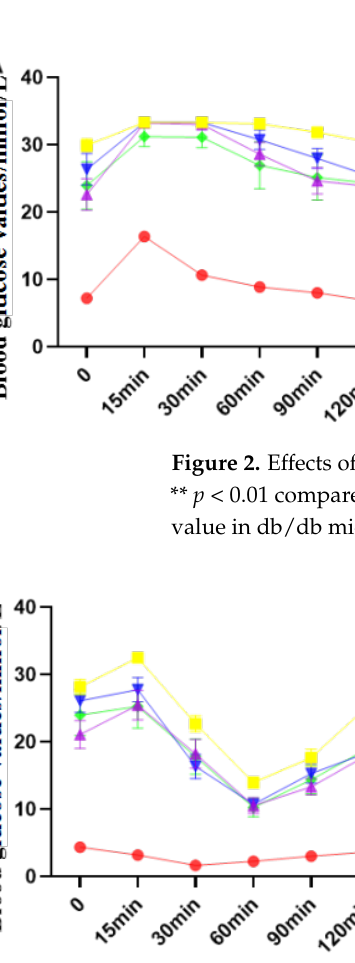
Figure 1. ( A ) Effect of Pueraria polysaccharide on body weight of db/db mice ( n = 10; ** p < 0.01 compared with the model group). ( B ) Effect of Pueraria polysaccharide on the water intake of db/db mice ( n = 10; ** p < 0.01 compared with the model group). ( C ) Effect of Pueraria polysaccharide on food intake of db/db mice ( n = 10; ** p < 0.01 compared with the model group). ( D ) Effect of Pueraria polysaccharide on fasting blood glucose in db/db mice ( n = 10; * p < 0.05; ** p < 0.01 compared with the model group).